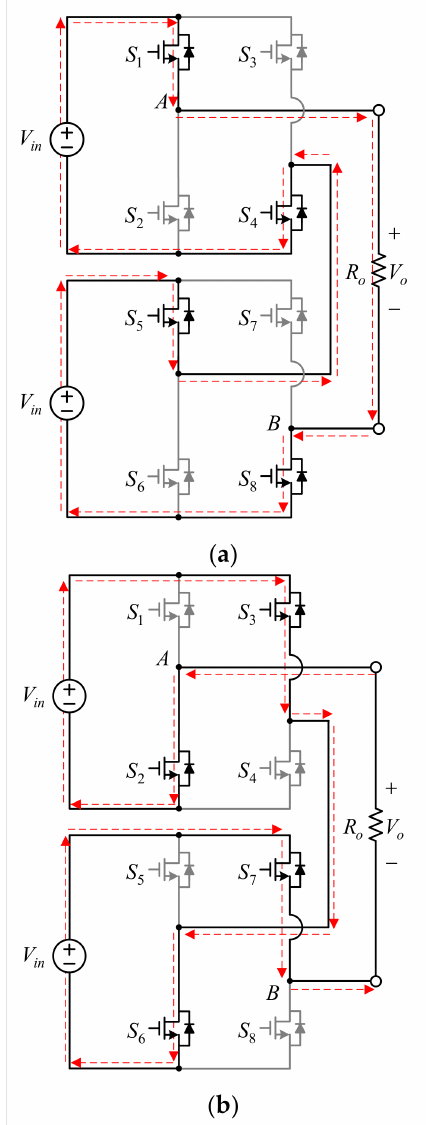
Figure 13. ( a ) Current flow direction of 2 V in voltage output; ( b ) current flow direction of − 2 V in voltage